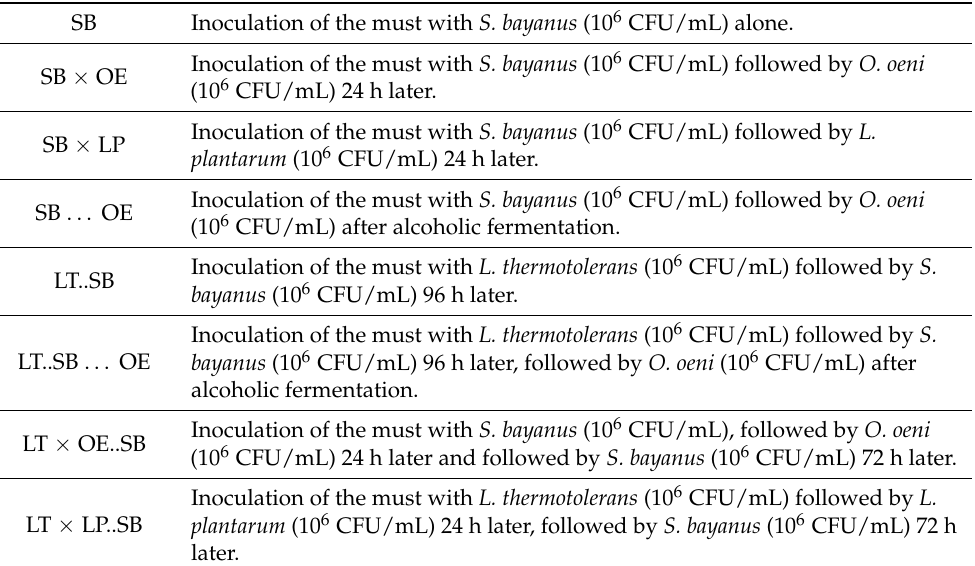
Table 1. Strain combinations used in each treatment. SB: S. bayanus , OE: O. oeni , LP: L. plantarum , LT: L. thermotolerans . × : 24 h, “..”: 96 h, “ . . . ”: until alcoholic fermentation is